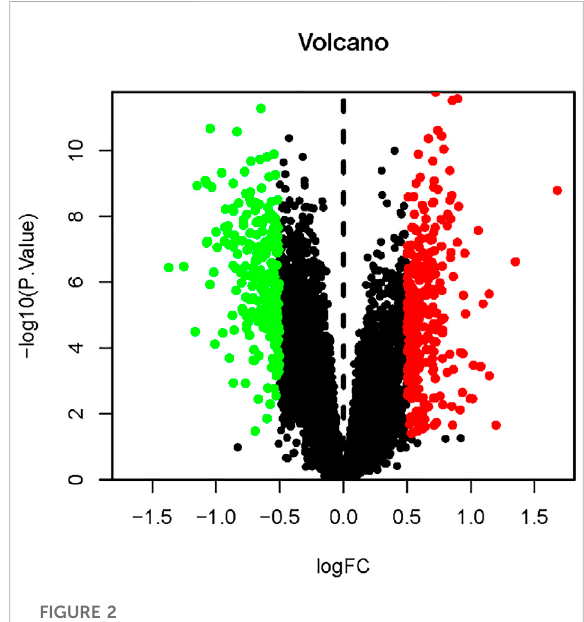
FIGURE 2 Volcano map of differential gene expression. Upregulated genes are indicated in red, downregulated genes are indicated in green, and black represents genes with no signi fi cant